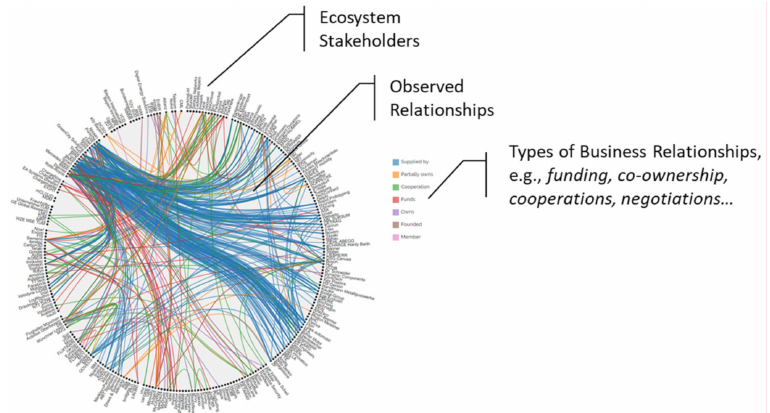
Figure 1. Structure of one visualization layout (chord diagram) to analyze urban ecosystem stake- holder